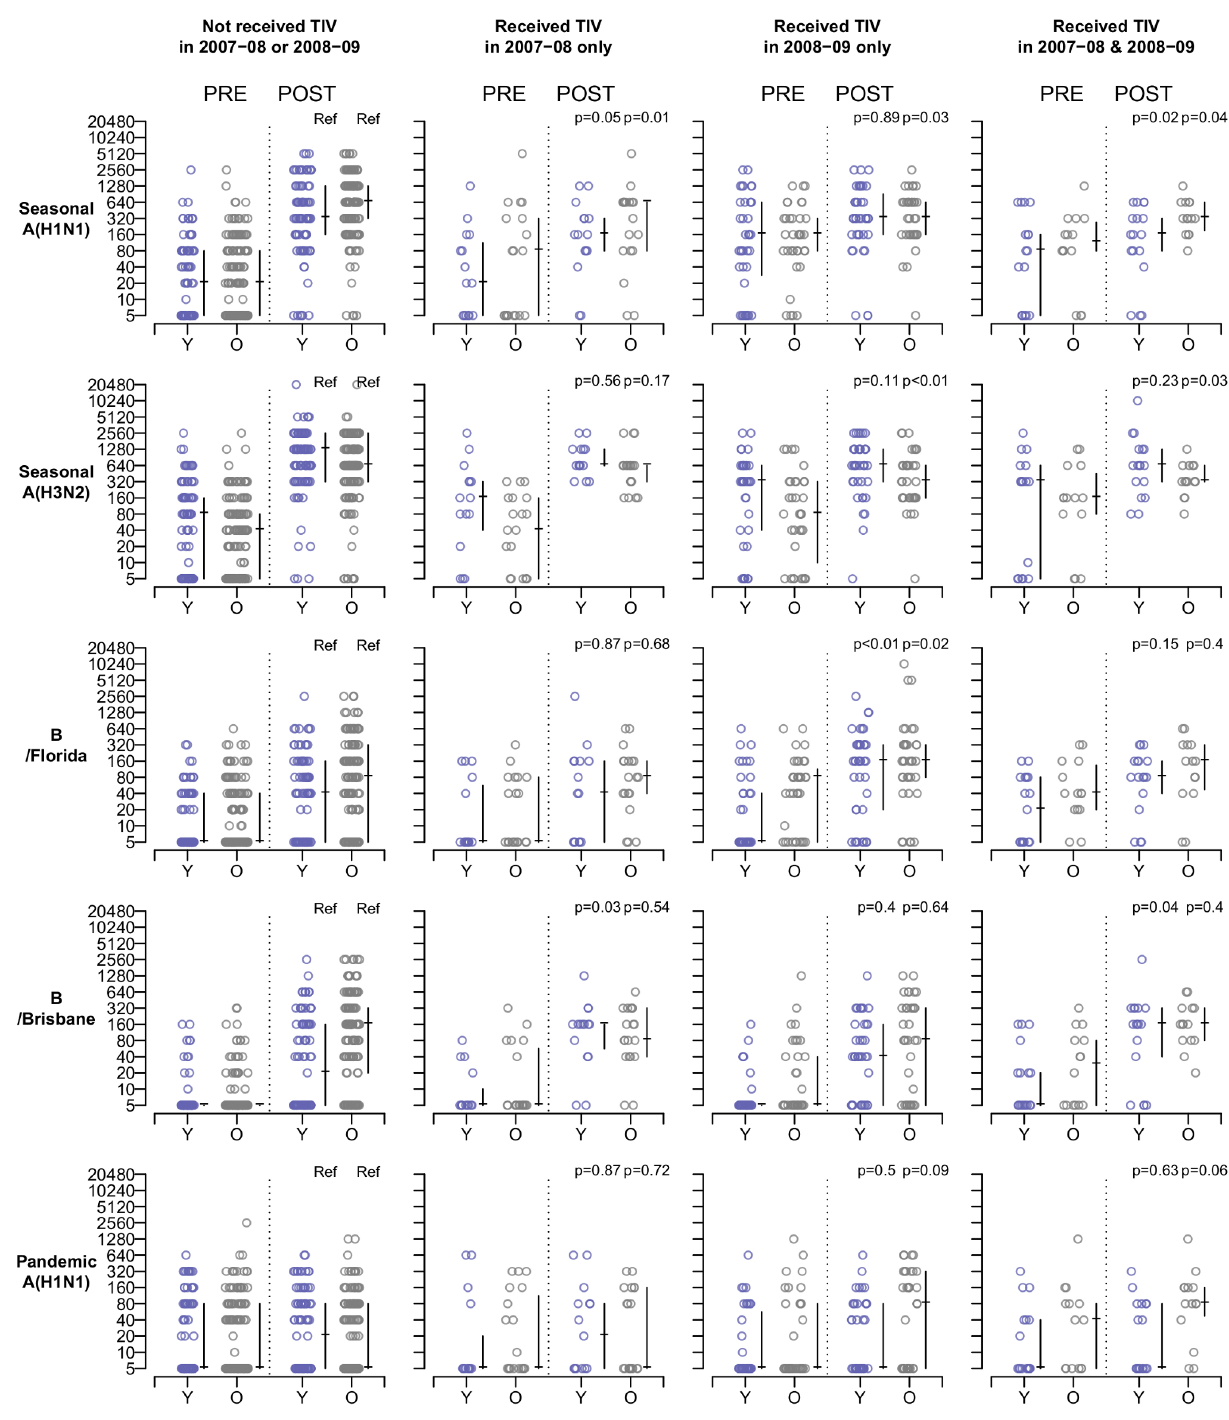
Figure 1. Individual antibody titers before and one month after receipt of trivalent inactivated influenza vaccine (TIV) in 2009–2010 among 6–8 y (Y, represented by blue circles) and 9–17 y children (O, represented by grey circles) with regard to their vaccination history for the 2007–2008 and 2008–2009 seasons. The median and interquartile range of antibody titers are shown, p-values were obtained by non parametric Wilcoxon signed rank tests. The comparisons were made with reference to children who were randomized to receive TIV in 2009– 10 but did not receive any TIV during 2007–2008 and 2008–2009 seasons. The two p-values shown in each plot were obtained by comparison with children of the same age in the corresponding reference group (6–8 y and 9–17